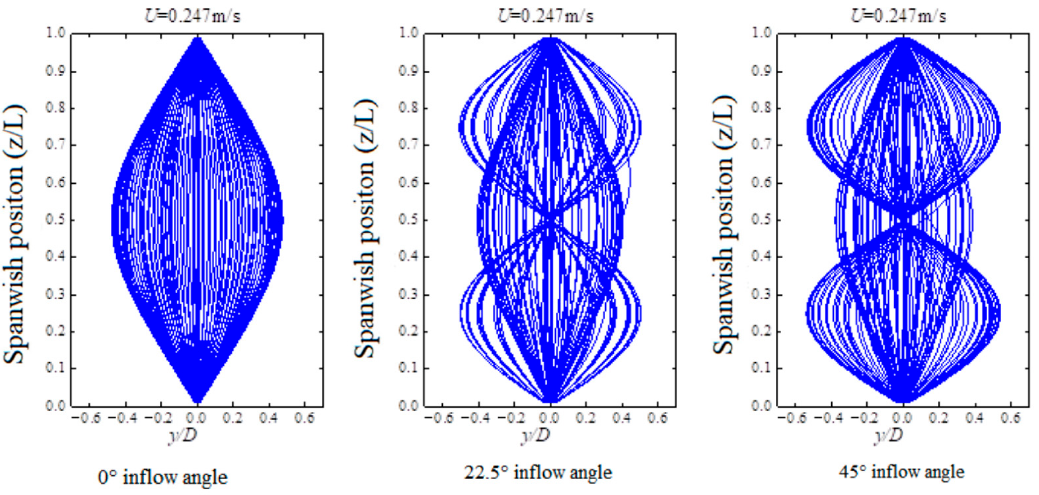
Figure 10. Displacement modal response of No. 4 tension leg under different inflow angles with Ur =